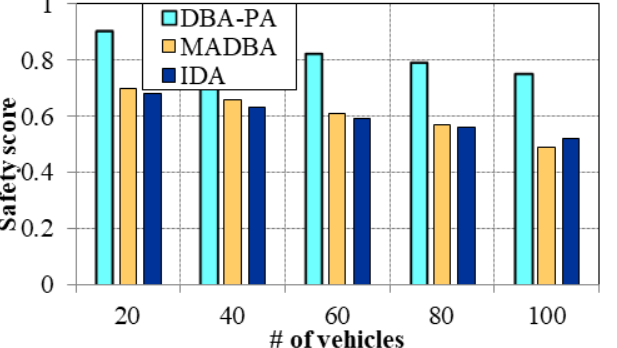
Figure 14. Number of Vehicles vs. Safety Scores.